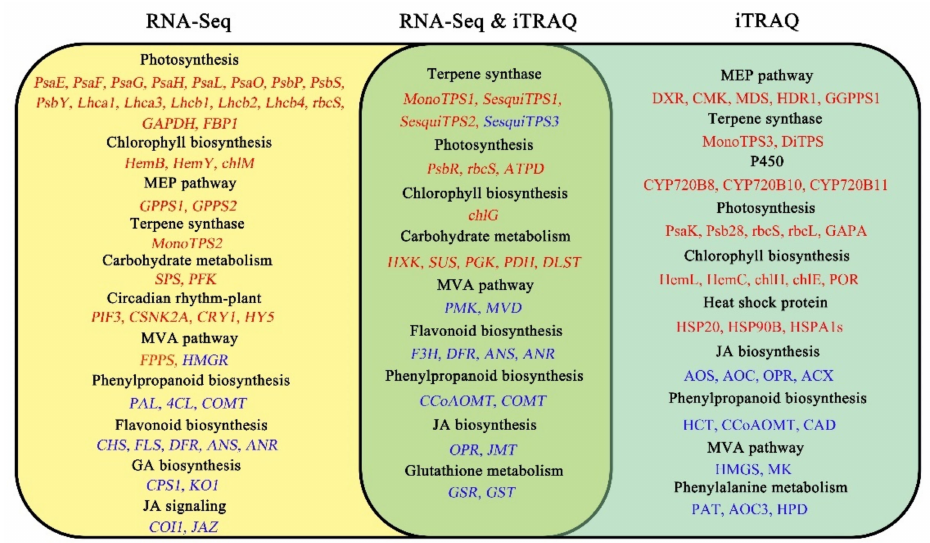
Figure 7. Representative pathways and candidate genes are significantly associated with the resin yield by RNA-Seq and iTRAQ integrative analysis. Up- and down-regulated DEGs/DEPs were indicated by red and blue colors,